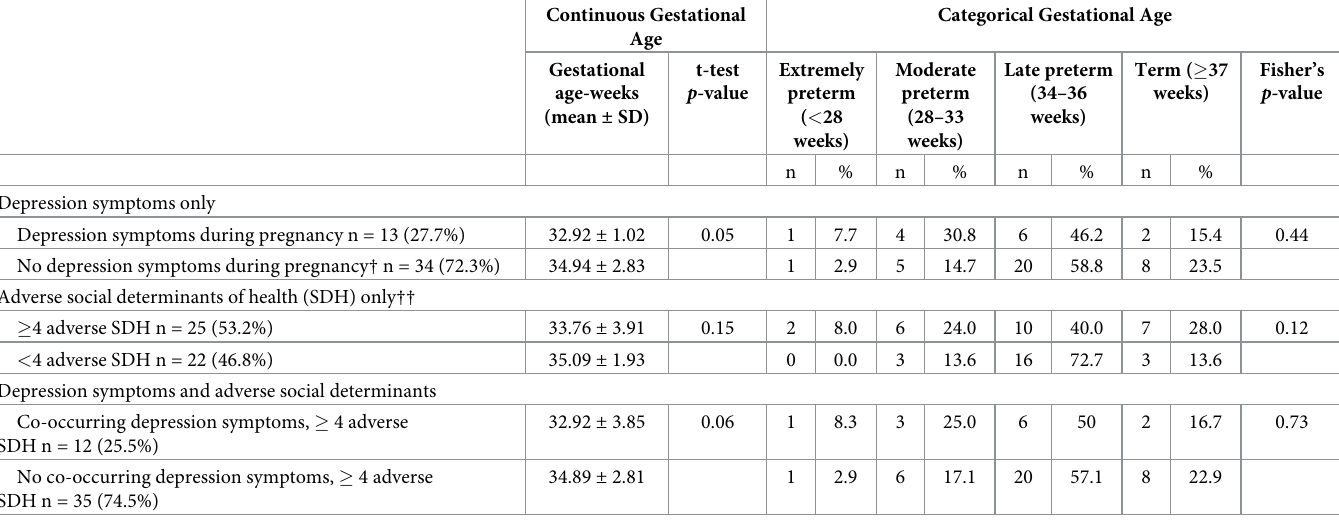
Table 2. Gestational age by depression symptoms and social determinants (n =